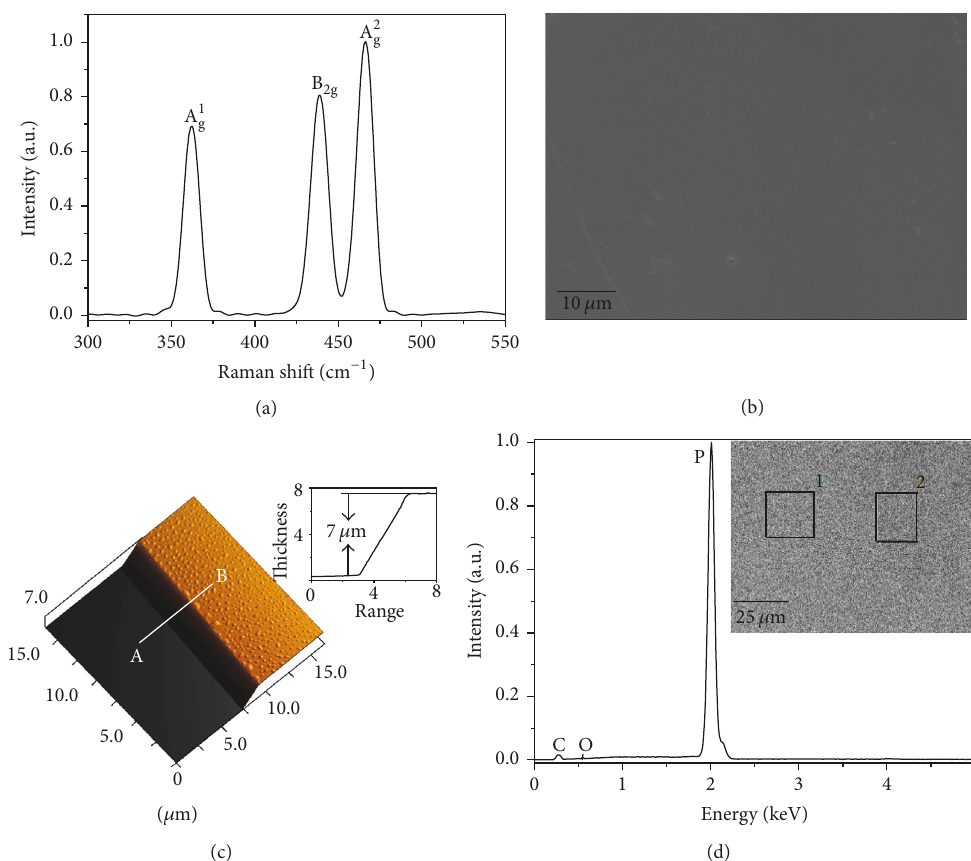
Figure 1: (a) Raman spectrum of the BP flake sample. (b) Morphology of BP flake measured by the scanning electron microscopy (SEM). (c) Three-dimension morphology of the BP flake scanned by the atomic force microscopy (AFM). Inset: height difference between mica sheet substrate (point A) and BP flake (point B). (d) Elemental components measured by the energy-dispersive X-ray spectroscopy (EDS). Inset: SEM image of BP